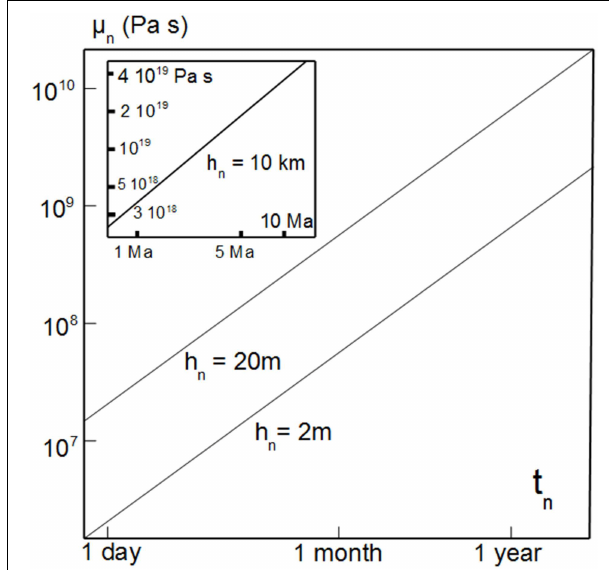
FIGURE 4 | The two lines of similarity show that experiments on thick (h n = 10 km) spreading nappes (Merle, 1982) (the line of similarity of this experiment is shown in the insert) also simulate the strain within thin lava flows (h n = 20 m and h n = 2 m). Both horizontal and vertical axes have log scales. Explanation in the text.